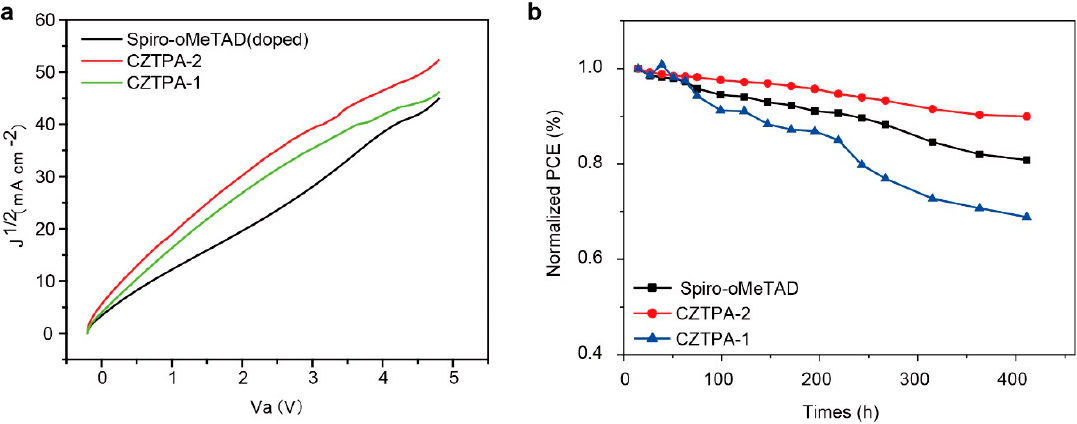
Figure 5. ( a ) Space-charge-limited current (SCLC) J 1 / 2 – V characteristics of CZTPA-1-, CZTPA-2-, and Spiro-OMeTAD-based hole-only devices measured in the dark. ( b ) Stability of CZTPA-1, CZTPA-2, and Spiro-oMeTAD (dopant-free) without encapsulation.